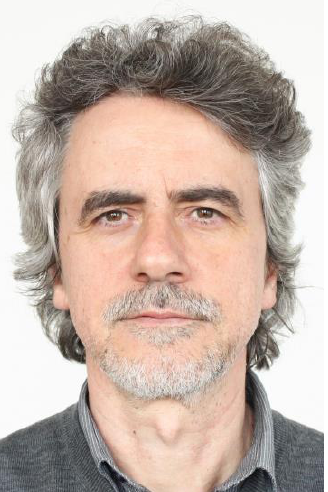
Figure A4. Peter Frolkovič.